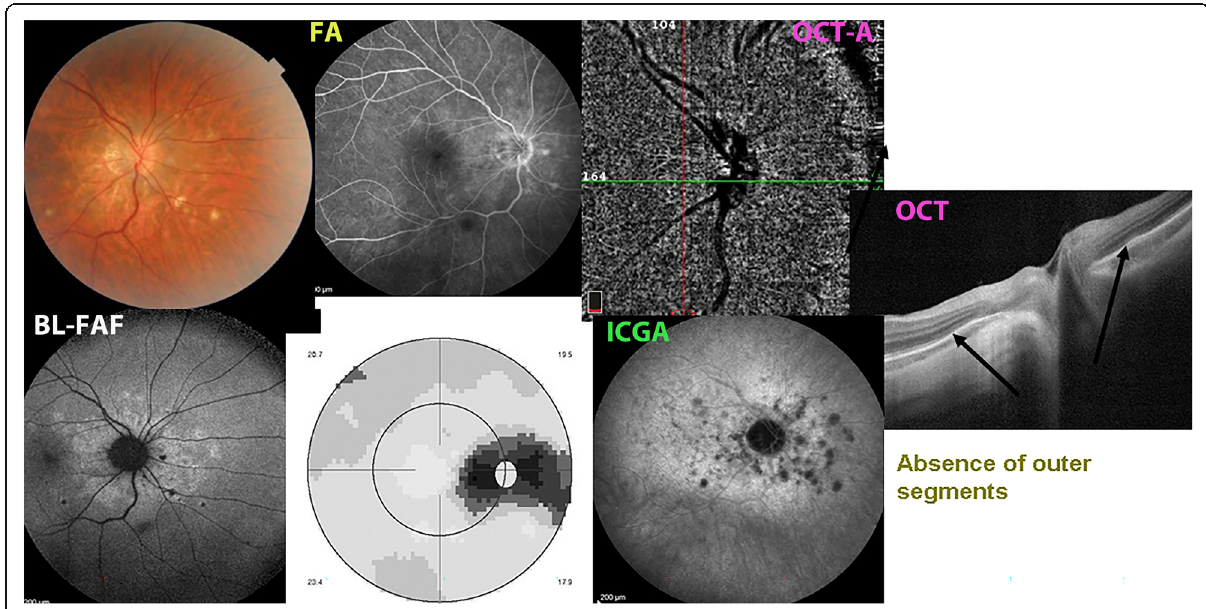
Fig. 7 Case of Multifocal choroiditis (MFC). Comprehensive multimodal imaging. Multiple yellow foci in fundus typically seen in MFC (top left). Circum-papillary hyperautofluorescence on BL-FAF picture (bottom left) without FA signs (top middle) and blind spot enlargement on visual field (bottom middle). ICGA hypofluorescence clearly shows occult choriocapillaris non-perfusion, corresponding to BL-FAF hyperfluorescence. Lesions are barely seen on OCT-A (top right), while OCT shows loss or damage to photoreceptor outer segments (extreme right picture)